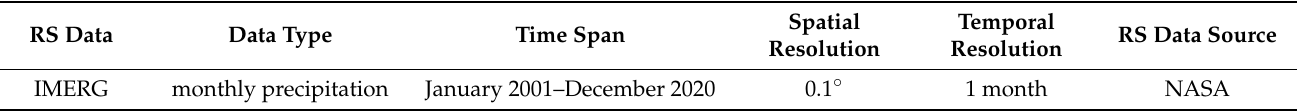
Table 2. IMERG used in this study.